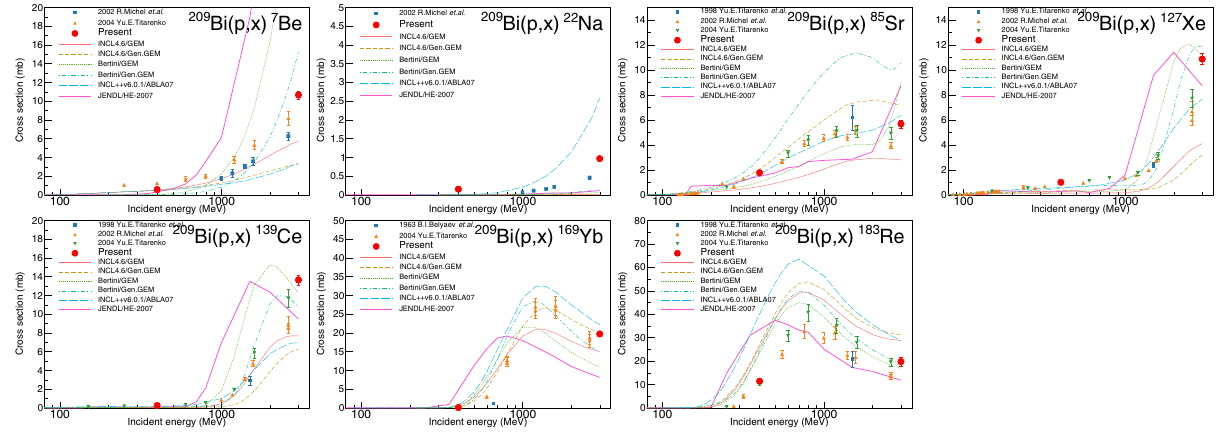
Figure 2. Production cross sections of 7 Be, 22 Na, 85 Sr, 127 Xe, 139 Ce, 169 Yb, and 183 Re from 209 Bi. This works (full circle), other experiments (other symbols) taken from EXFOR, calculations (solid and dashed lines), and the evaluated data (bold line) are